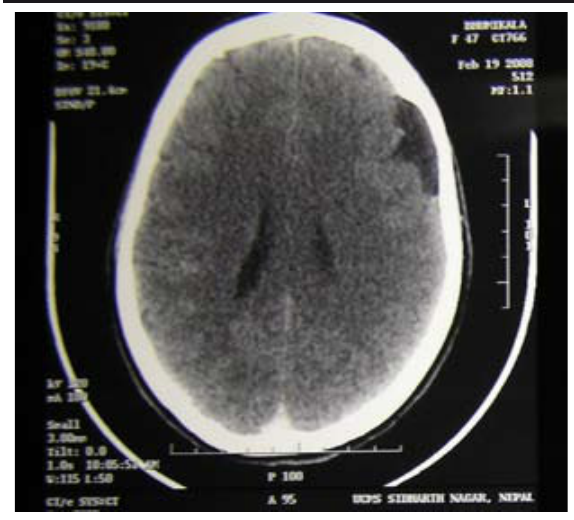
Figure 1. Ct scan showing